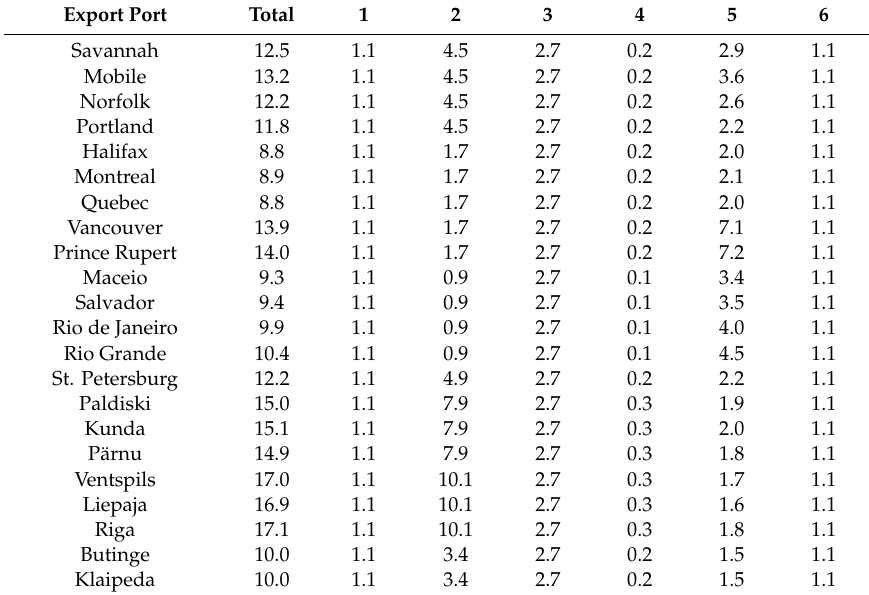
Table A12. Overview of supply chain GHG emissions of pellets produced from sawmill residues, transported over 500 km to export ports and including 50 km feedstock transport, in kg CO 2 -eq / t pellets. Components included in the table: 1. Silviculture and harvest; 2. Feedstock transport; 3. Pelletizing; 4. Pellet transport; 5. Shipping; 6. Port operations.